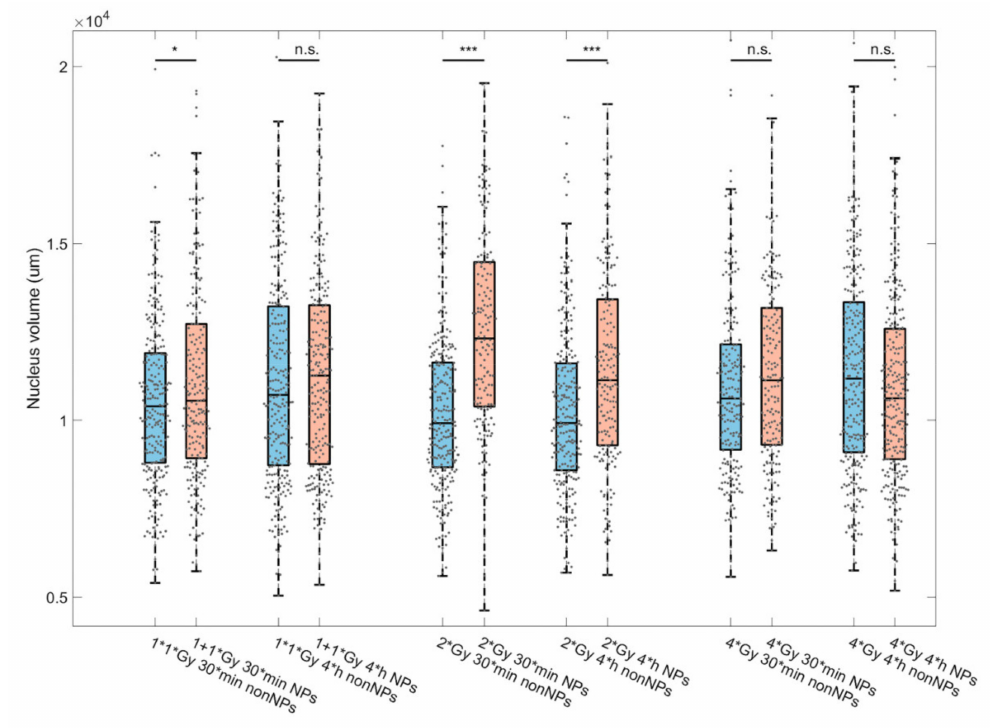
Figure 6. Volumes [ µ m 3 ] of SkBr3 cell nuclei compared for cell specimens exposed to 0, 1 + 1, 2 or 4 Gy of γ -rays in the presence ( orange ) or absence ( blue ) of GNPs (0.4 µ g/mL). Asterisks denote statistical significance of differences between indicated samples at p = 0.05 (*), p = 0.01 (**) or p = 0.001 (***); ns = not significant. Two-tailed t -test, two-tailed t -test with Welsh correction or Mann–Whitney Rank Sum Test was used depending on the distribution normality of the analyzed